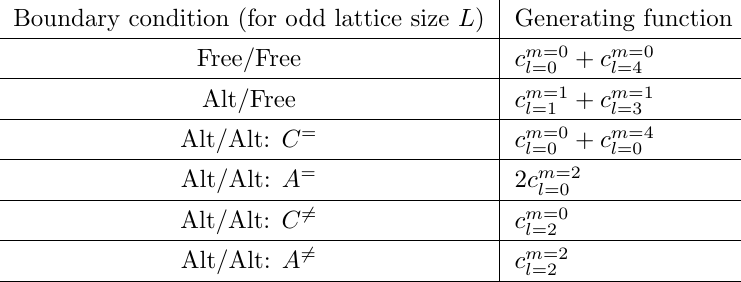
Table 4 . Boundary conditions and their continuum limits. As explained in the text there are four independent \alt/alt" boundary conditions. The precise meaning of the labels of these four types are explained in (cid:12)gures 24 and 25. The boundary conditions written above are those taken for L odd. See the main text for a discussion on the relevance of the parity of L